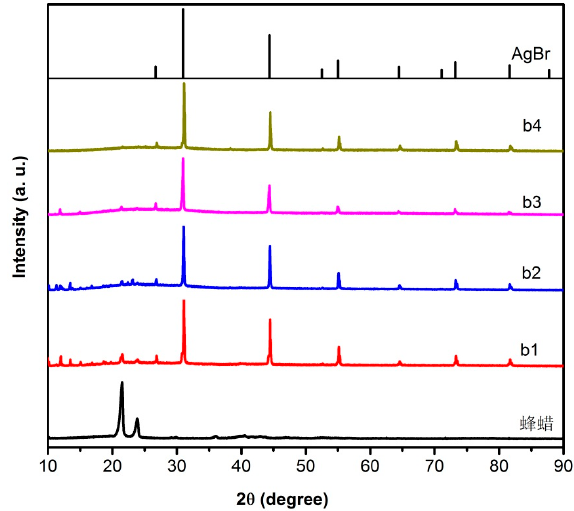
Figure 5. X-ray diffraction of SA, PA, AgBr, and prepared nanocapsules.